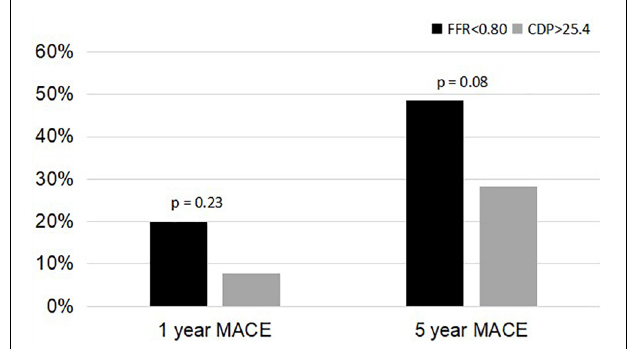
FIGURE 4 | Comparison of %MACE between the FFR < 0.80 group and the CDP > 25.4 groups at 1 and 5 years. MACE, major adverse cardiac events; CDP, pressure drop coefficient; FFR, fractional flow